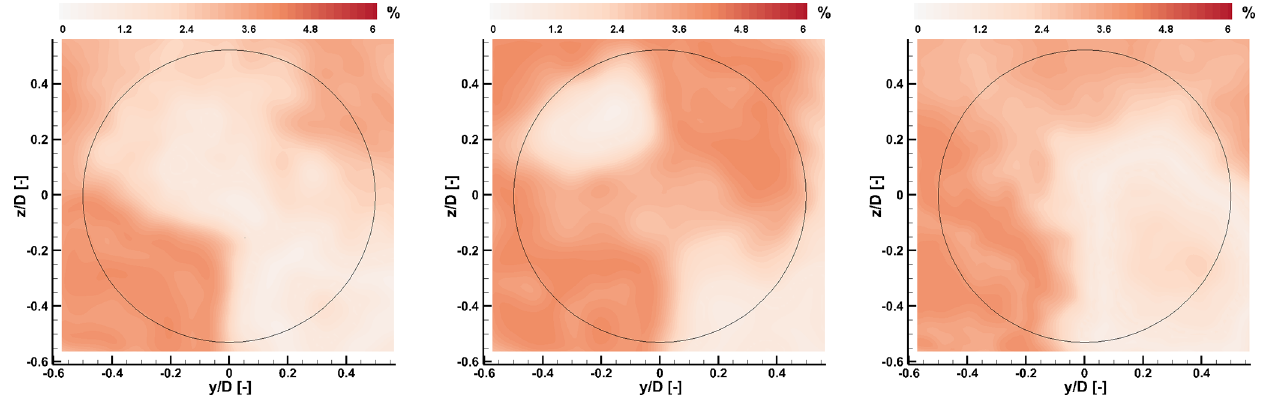
Figure 4. Absolute percent error between S-PIV and CFD time-averaged streamwise flow speed 5 D downstream of the rotor, for three tilt angles. The black circle denotes the rotor circumference.